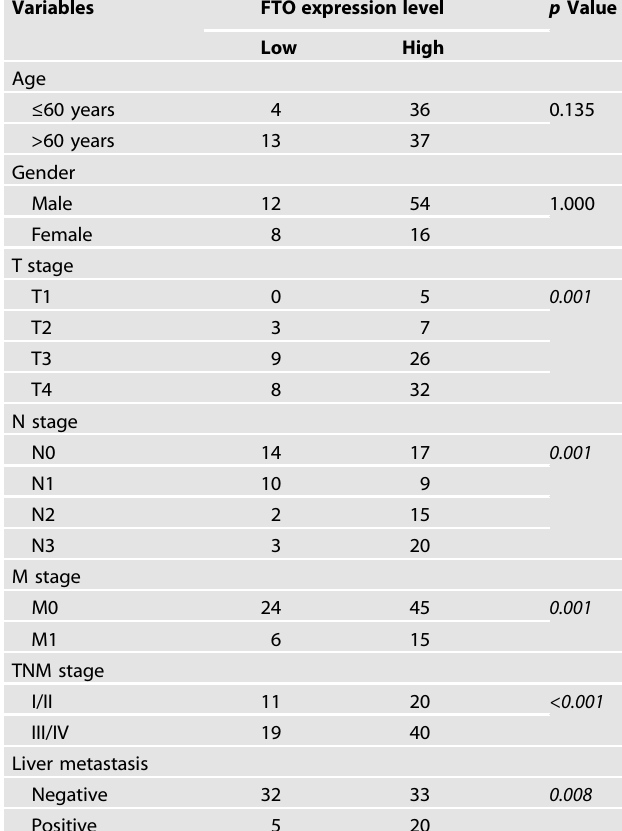
Italic font signi fi es p